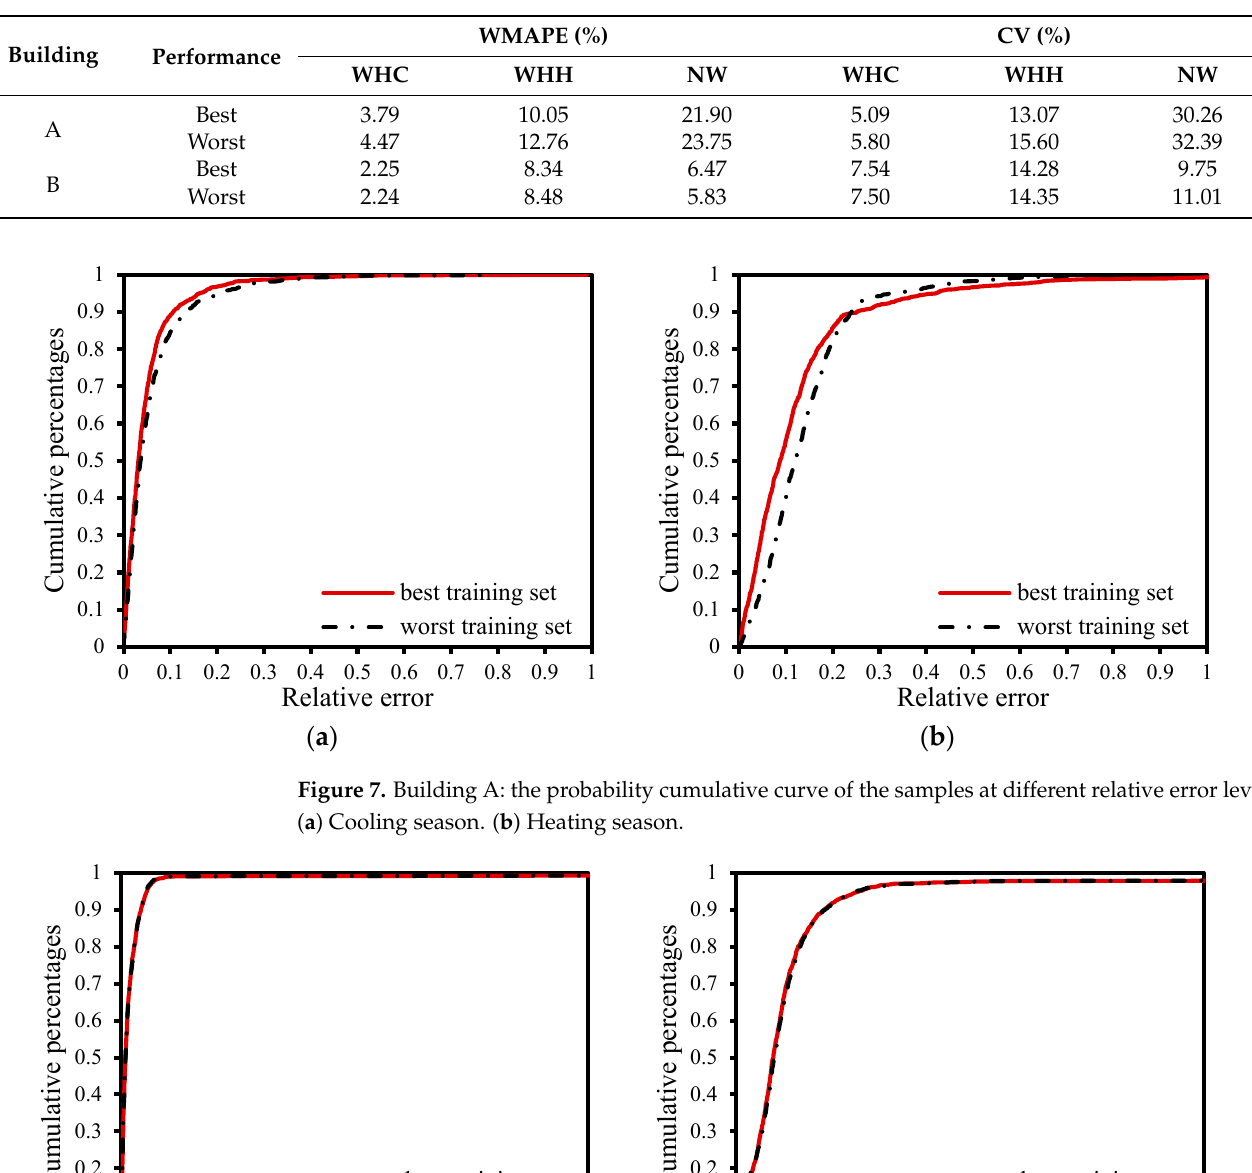
Table 10. Electricity consumption disaggregation results of HVAC terminal units.